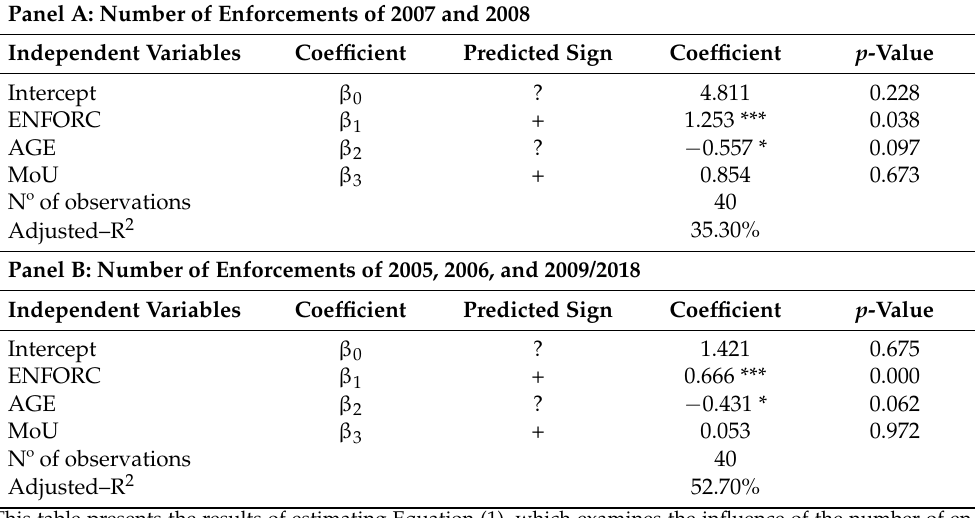
Table 4. Association between the number of enforcements and the complexity of an accounting standard by